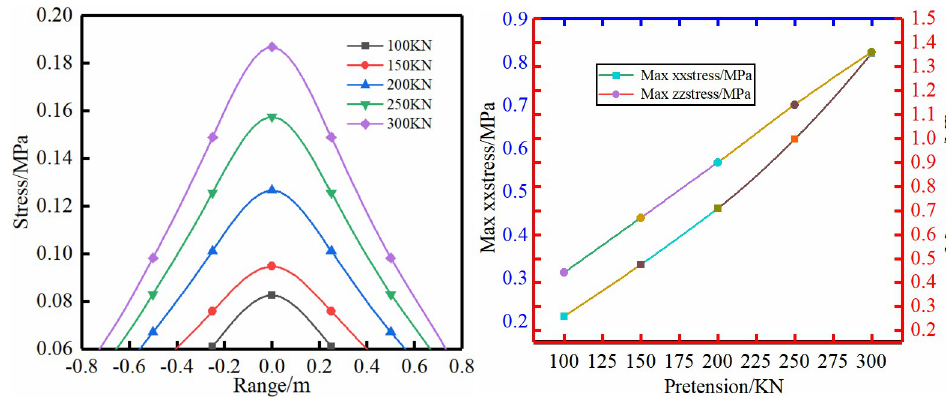
Fig 6. Different pretension.